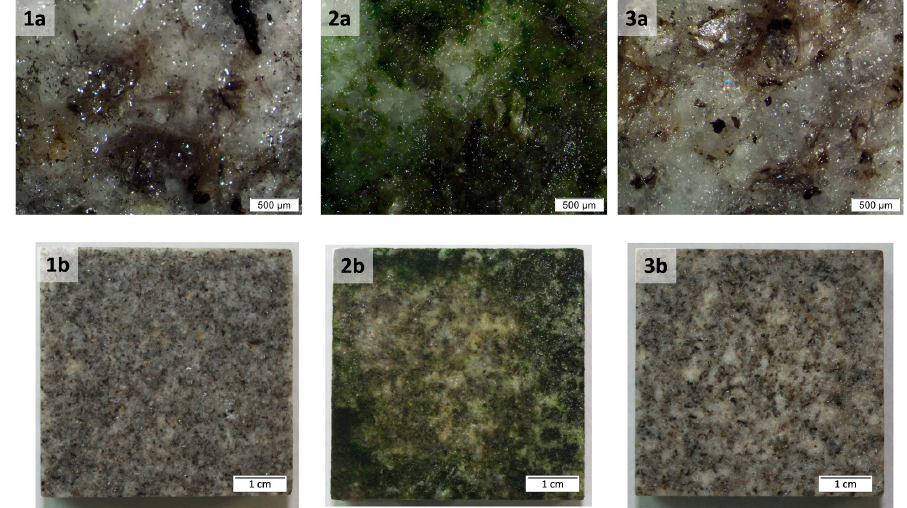
Figure 5. Granite samples ( a ) examined under a stereoscopic microscope Nikon Eclipse E600, Tokyo, Japan. Scale bar is 500 µ m. ( b ) photographed with a macro lens Tamron SP 90mm F / 2.8 Di MACRO 1:1. Scale bar is 1 cm. ( 1 ) Uncolonized, ( 2 ) colonized, ( 3 ) cleaned with C. Nepeta (T3).